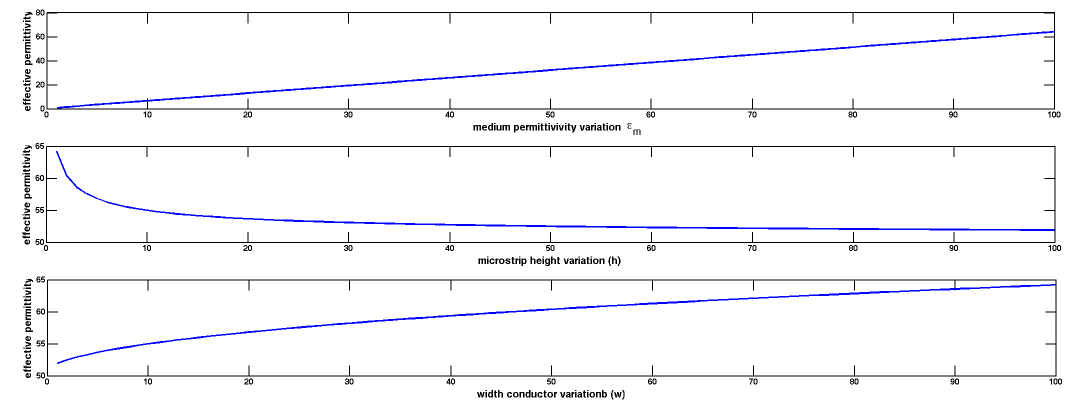
Figure 10. Sensitive analysis to determine how different values of dielectric medium ( (cid:101) m ) and microstrip dimensions (h and w) impact on effective permittivity ( (cid:101) ef f ) shown in Equation (10).